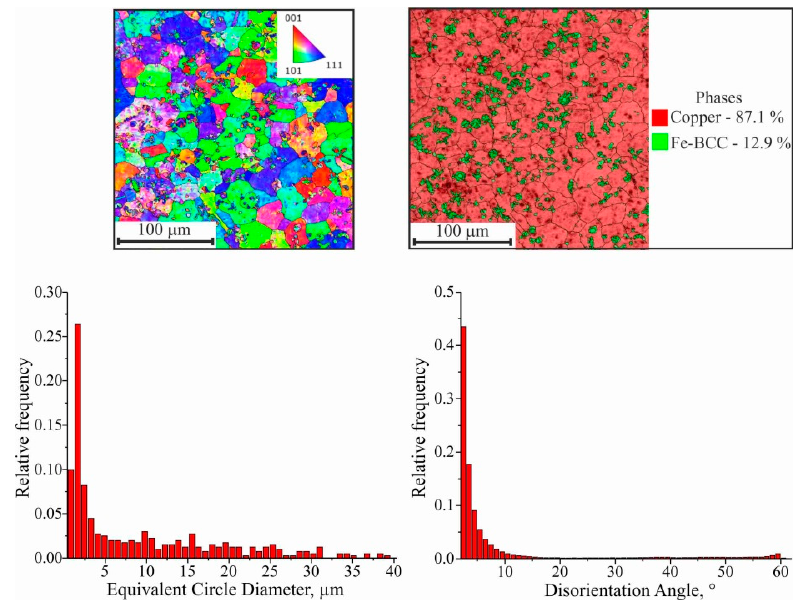
Figure 12. EBSD map fragment; grain size; disorientation; scattered and contoured IPFs; phase map (Cu: red color, Fe: green color).